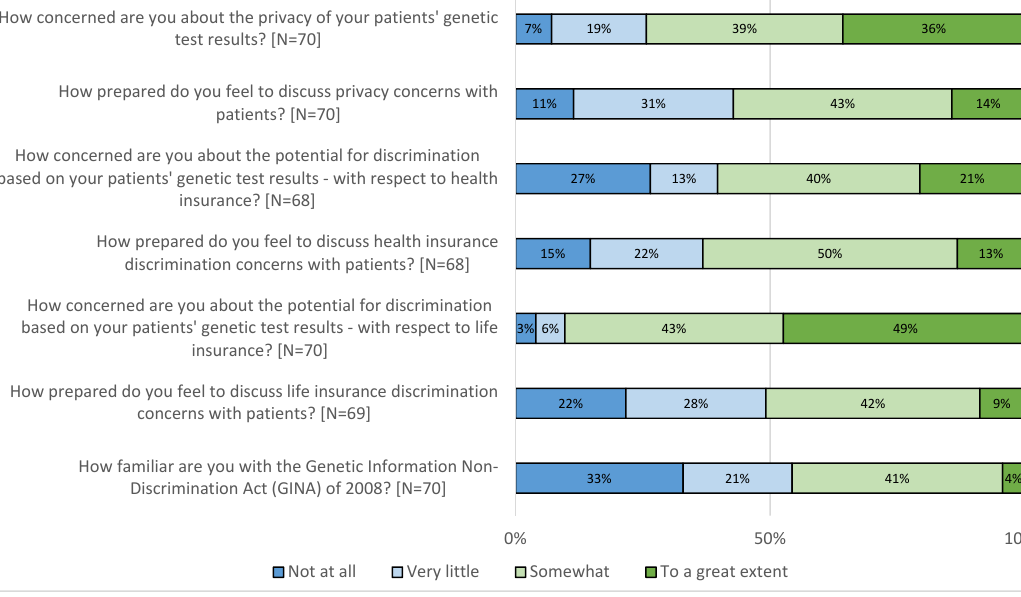
Figure 1. Primary care providers’ (PCP) concern about and preparedness to discuss privacy and insurance discrimination.